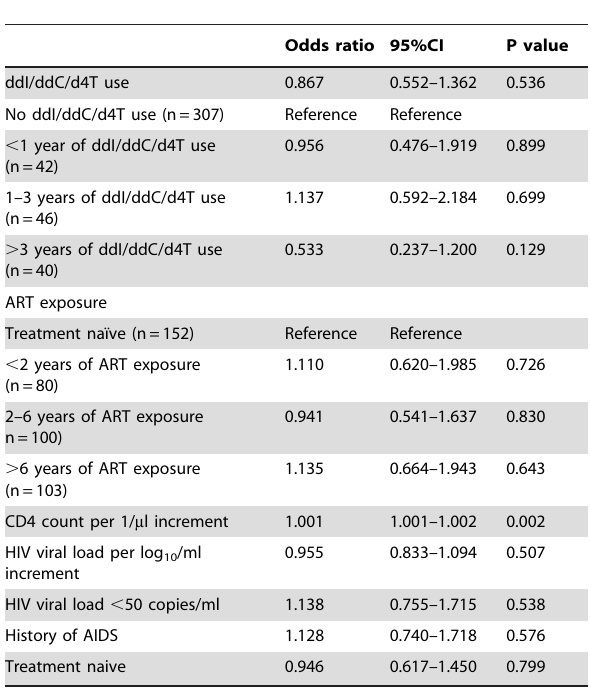
Table 3. Univariate analysis to estimate the association of HIV-specific variables with nonalcoholic fatty liver disease.